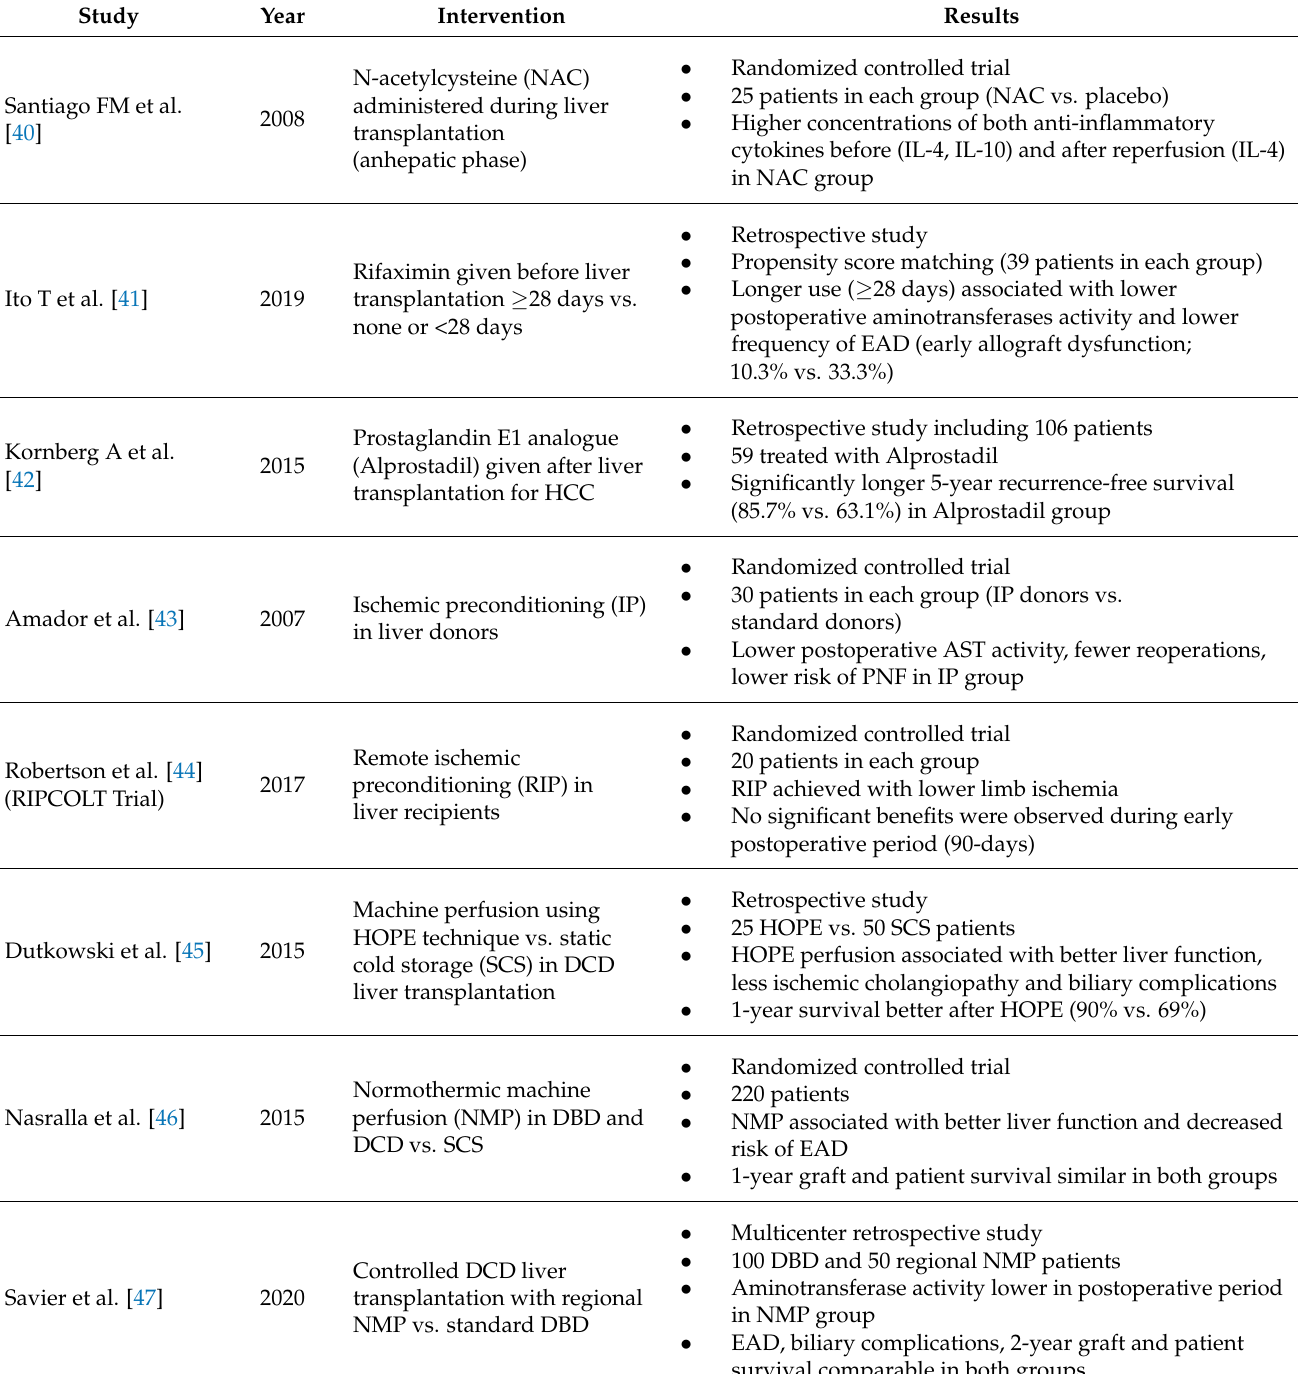
Table 2. Selected studies assessing various mitigation strategies against